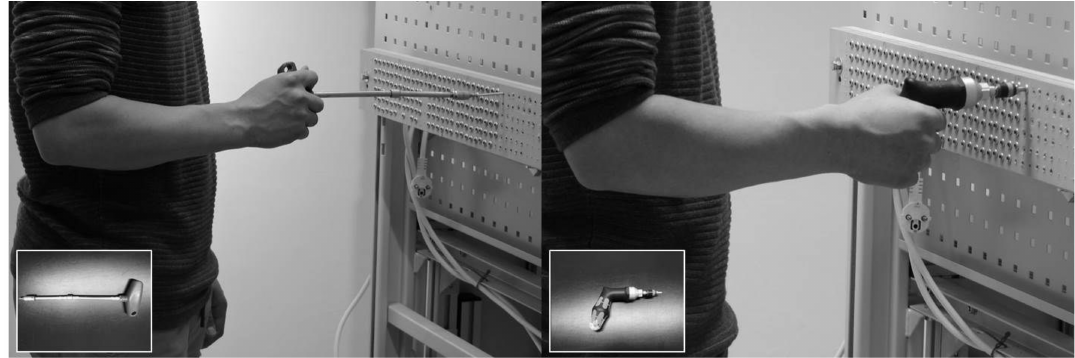
Figure 1. Experimental task setup with an example of screwing using the t-handle screwdriver (left) and an example of fastening using the torque screwdriver